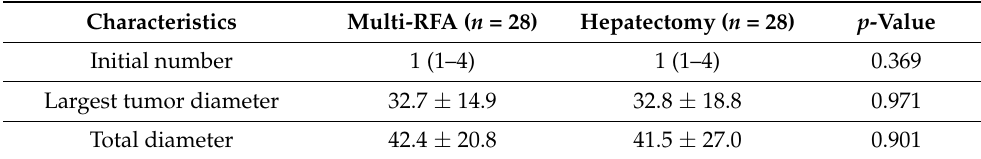
Table 7. Characteristics of initial liver tumor metastases after